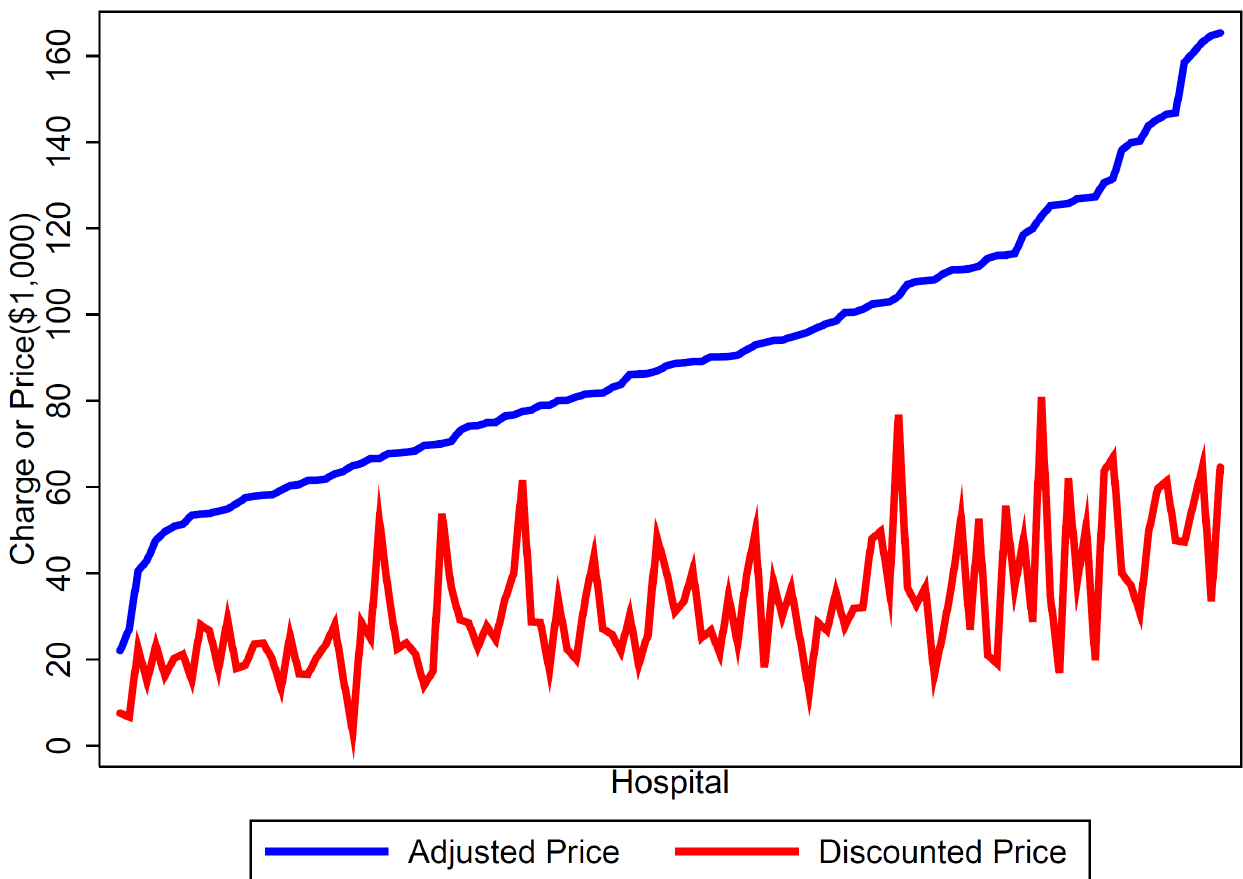
Figure 2. Discounted prices versus adjusted charges, by hospital. Hospitals are placed in order along the x-axis by charge for the average patient admitted for MS-DRG 247 (blue). The corresponding discounted price (estimated paid by a private insurer) is represented in red.